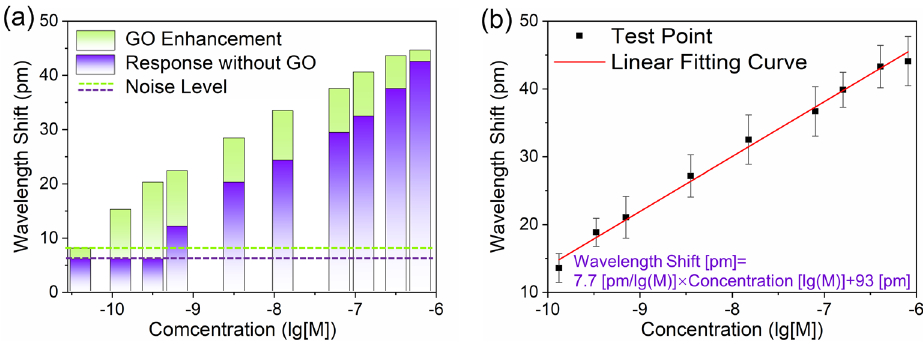
Figure 8. ( a ) The comparison in wavelength response of the FBG sensor to different IgG samples before and after GO-coating. ( b ) Wavelength shift of the GO-coated FBG sensor as a function of the IgG concentration on a logarithmic scale.